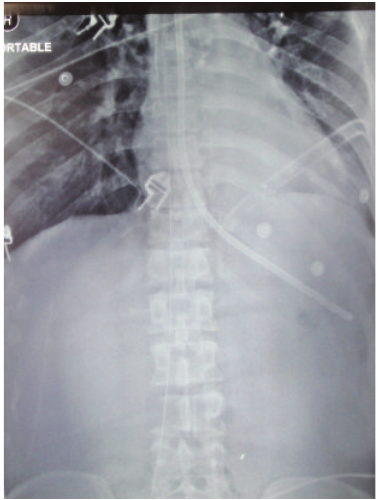
Figure 2: Upper abdominal X-ray showing the lost guidewire extending down the inferior vena cava on the right side of the abdomen.